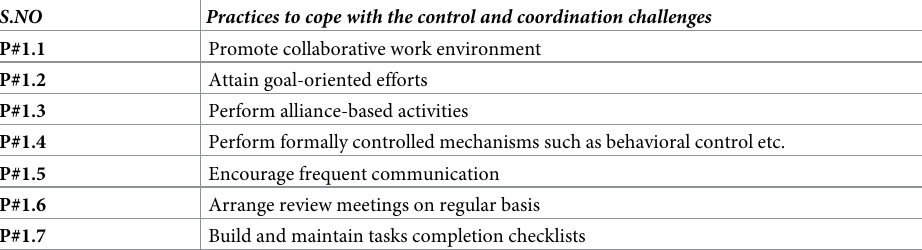
Table 4. Practices to cope with control and coordination challenges in